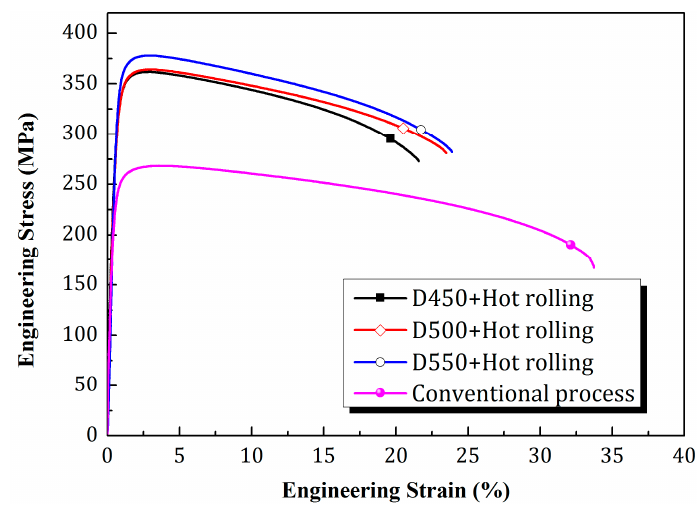
Figure 7. Engineering stress-strain curve of Al / Ti LMCs after hot rolling.